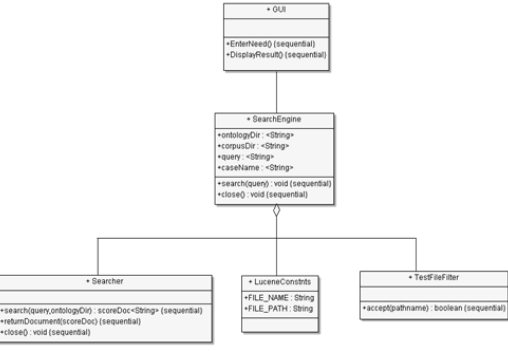
Fig. 3. Class diagram for the Law-Torch system.